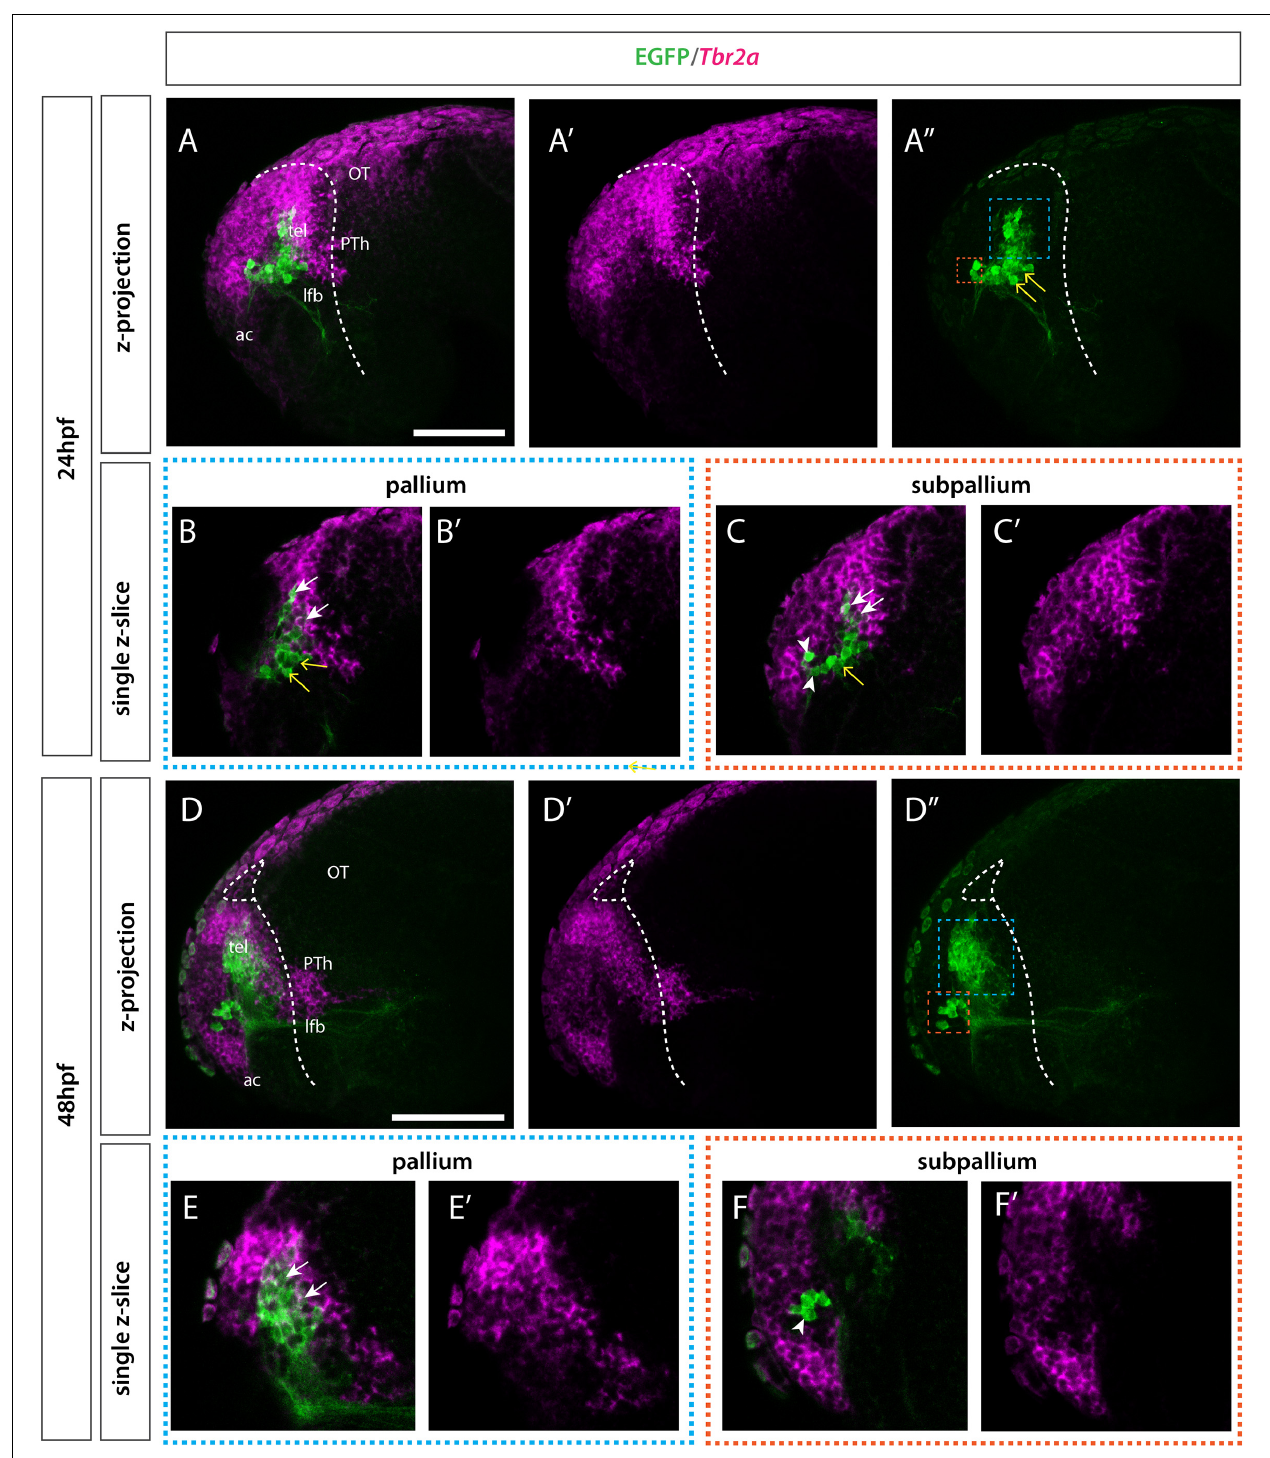
FIGURE 6 | Et( gata2:EGFP ) bi105 line expression in combination with tbr2a. Lateral view of Et (gata2:EGFP) bi105 fish labeled with anti-GFP (green) and FISH for tbr2a (magenta) at 24hpf (A–C (cid:48) ) and 48hpf (D–D (cid:48)(cid:48) ). Rostral to the left. Images are projections for z-stacks (A–A (cid:48)(cid:48) ,D–F (cid:48) ) or single-confocal z-slices ( B,B (cid:48) ,C,C (cid:48) ,E,E (cid:48) ,F,F (cid:48) ) . (A (cid:48)(cid:48) ,D (cid:48)(cid:48) ) Blue whisker box contains EGFP+ pallial cells; orange whisker box contains subpallial cells. (B,B (cid:48) ,E,E (cid:48) ) Sagittal section through pallial cells. (C,C (cid:48) ,F,F (cid:48) ) Sagittal section through subpallial cells. Arrows indicate pallial EGFP+ cells that express tbr2a. Arrowheads indicate subpallial EGFP+ cells that do not express tbr2a. Yellow arrows indicate EGFP+ cells in the ventral pallial domain (population B) that do not express tbr2a at 24hpf. By 48hpf the intermediate cells (yellow arrow) have resolved into the two distinct pallial/tbr2a+ and subpallial/tbr2a- populations. Dotted white line indicates the telencephalic ventricle. Scale bars: 50 µ m.